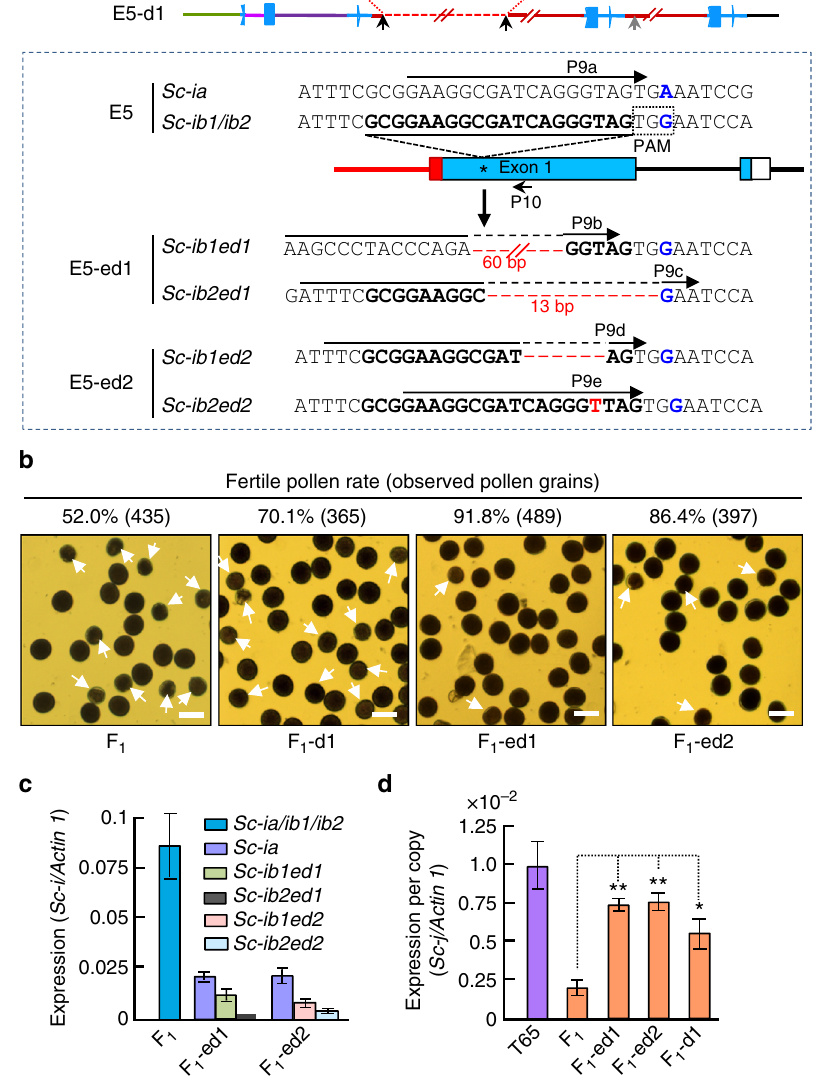
Fig. 4 Genomic editing of the Sc-i paralogs rescues Sc-j expression and male fertility in the hybrids. a Targeted editing of the sites (arrowed) in E5 produced a plant (E5-d1) with deletion of one of the ~ 28-kb segments (Supplementary Fig. 6), and editing another site (underlined) speci fi c to Sc-ib1 and Sc-ib2 of E5 identi fi ed two plants (E5-ed1 and E5-ed2) with mutated Sc-ib1 and Sc-ib2 and intact Sc-ia (Supplementary Fig. 10). The SNP (blue) in Sc-ib1 and Sc-ib2 formed the PAM (NGG) required for genome editing. Primers P9a-P9e combined with the Sc-i -speci fi c P10 were used for qRT-PCR of the intact and mutated Sc-i transcripts show in ( c ). b Improvement of pollen fertility (sterile pollen grains arrowed) in the edited F 1 plants from crossing E5-d1, E5-ed1, and E5-ed2 with T65. Scale bars, 50 μ m. c Expression levels (in the meiocyte stage anthers) of the Sc-i paralogs in the F 1 (T65/E5), and the intact Sc-ia and mutated Sc-ib1 / Sc-ib2 in the edited F 1 plants. Data are shown as means ± s.e.m. ( n = 3). d Expression levels of per copy Sc-j (qRT-PCR using P1/P2) in the early-bicellular stage anthers of the intact and edited F 1 plants and T65. The data are shown as means ± s.e.m. ( n = 3), and * and ** indicate signi fi cance at P < 0.05 and P < 0.01, respectively, by two-tailed Student ’ s t test